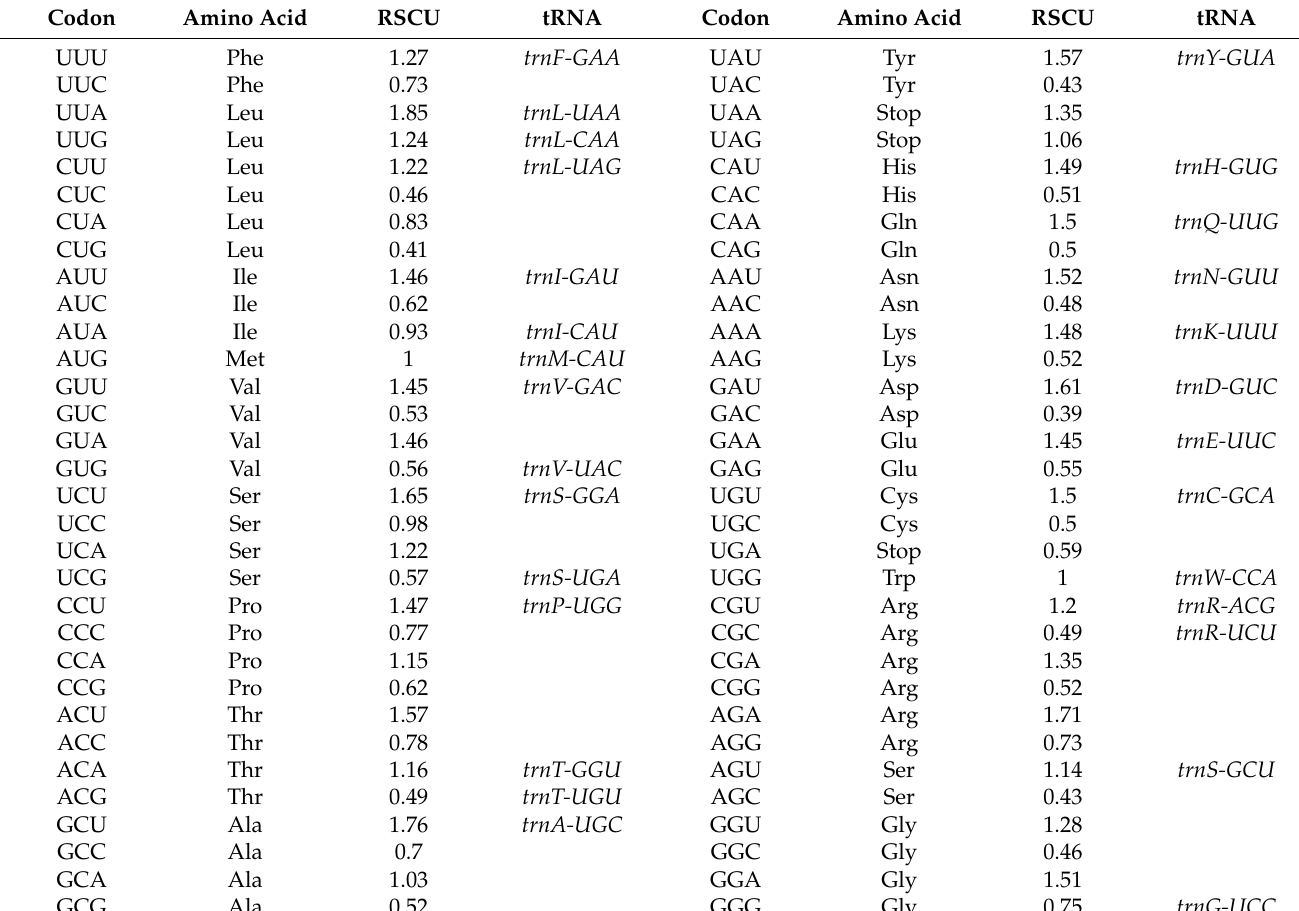
Table 4. Codon–anticodon recognition patterns and codon usage of the A. fruticosum chloroplast genome. Codon Amino